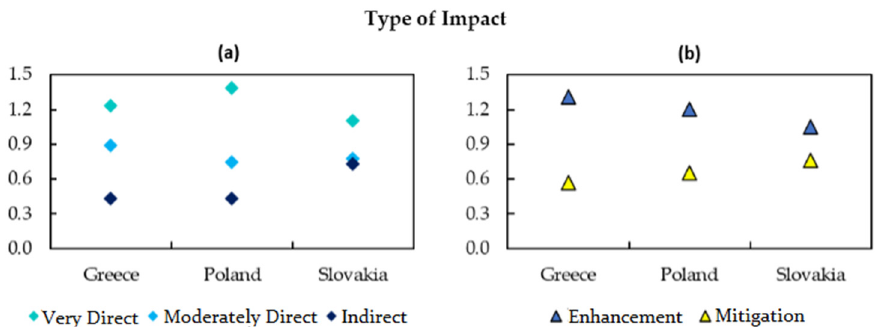
Figure 4. Summary of the stakeholders survey results regarding the average significance of SDGs in the RM sector for the three ESEE countries examined, as per the type of impact: ( a ) Very Direct, Moderately Direct, Indirect, and ( b ) Enhancement and Mitigation, EBRD [18].